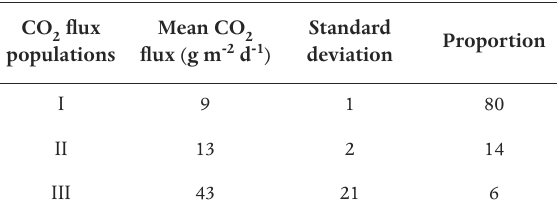
flux populations. 2